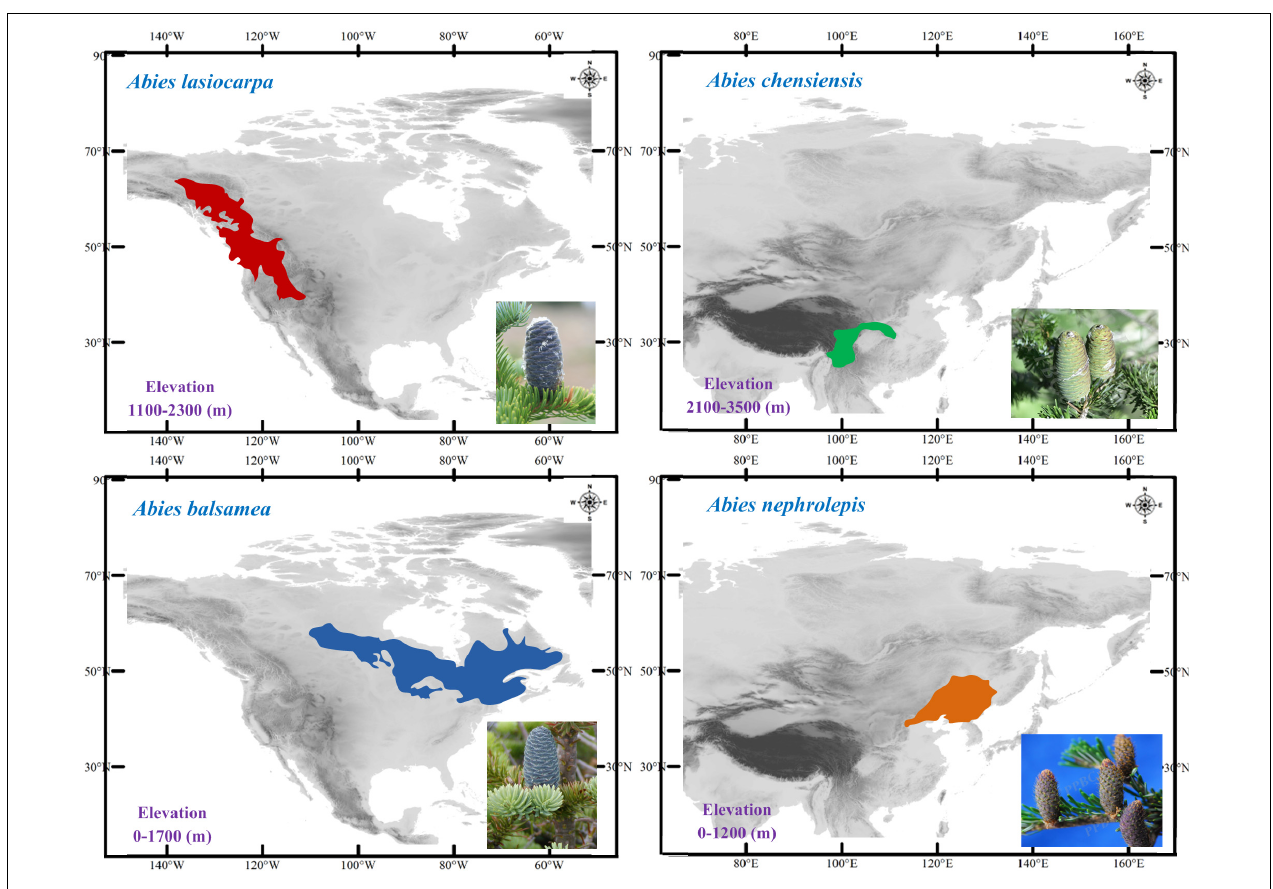
FIGURE 2 | Distribution ranges of the four fir